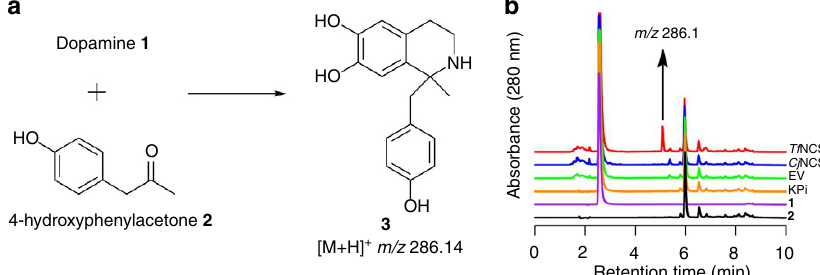
Figure 3 | NCS activity with 4-hydroxyphenylacetone. ( a ) Proposed enzyme catalysed Pictet–Spengler condensation between dopamine 1 and an unactivated ketone (4-hydroxyphenylacetone 2 ). ( b ) HPLC analysis of reactions between 1 and 2 . Substrates 1 and 2 were incubated together with phosphate buffer (KPi), control lysate with empty vector (EV), lysate containing D 21 Cj NCS2 or lysate containing D 29 Tf NCS. Formation of a new compound was observed in the Tf NCS sample. When analysed by MS, this compound had an m/z of 286.1, corresponding to THIQ 3 .